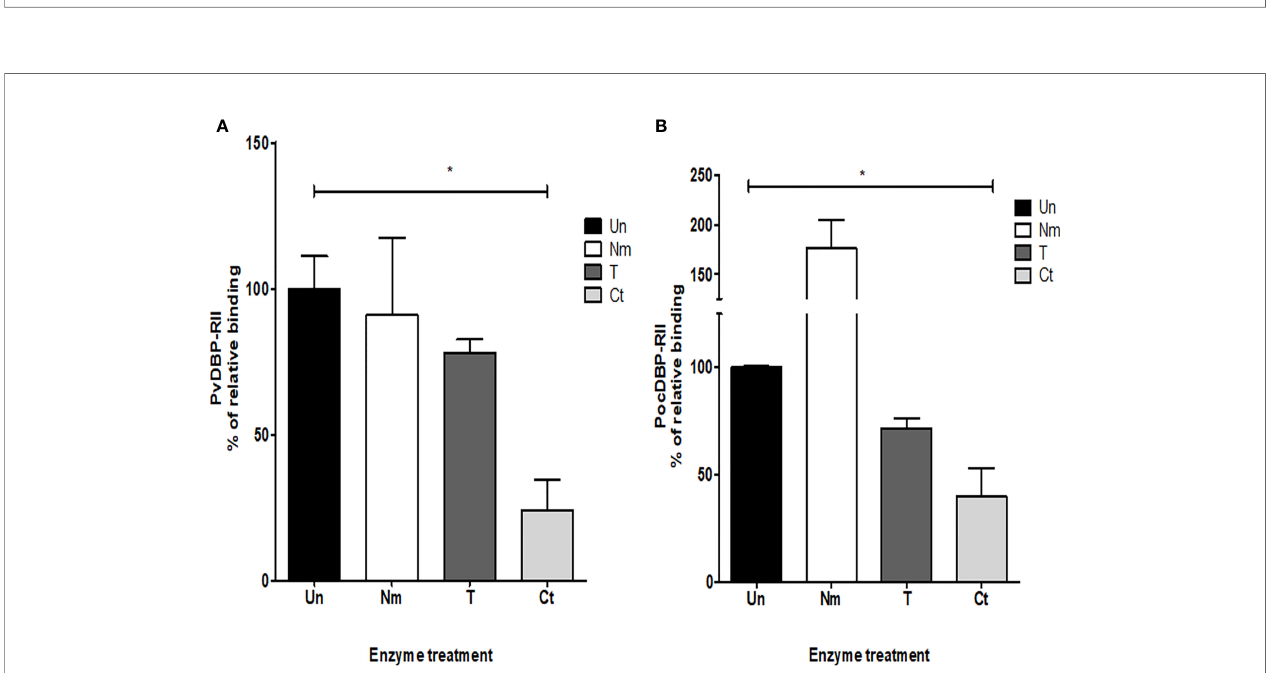
FIGURE 6 | Enzyme-treated reticulocyte binding assay. A fl ow cytometry-based erythrocyte binding assay of PvDBP-RII (A) and PocDBP-RII (B) was performed with different enzyme-treated erythrocytes: Un, untreated RBCs; Nm, neuraminidase; T, trypsin; Ct, chymotrypsin. Signi fi cant differences are shown as single asterisks, p < 0.05. The data are shown as the mean ± standard deviation of at least two independent